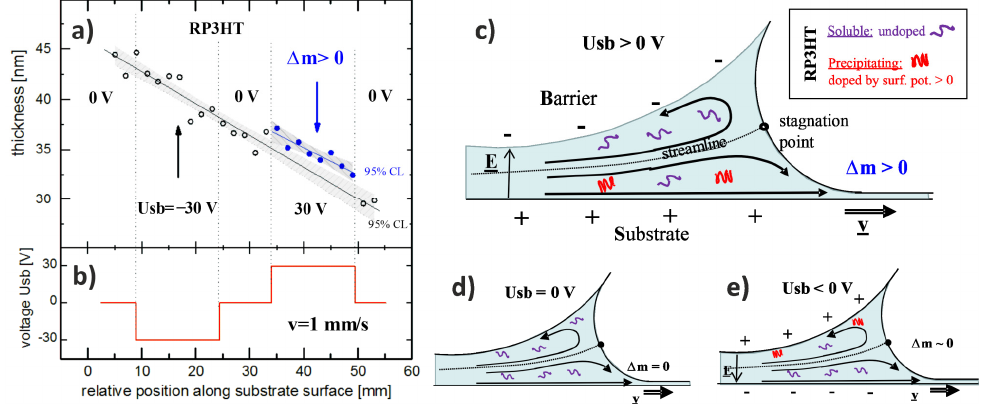
Figure 5. Electrically controlled content of RP3HT in the solution-coated films based on a novel mechanism involving ( a , b ) voltage-controlled RP3HT solubility and ( c – e ) flow pattern asymmetry between the stationary barrier and moving substrate during the H-dip coating process. The film thickness of a pristine RP3HT layer ( a ), determined after H-dip coating (from chlorobenzene, 15 mg/mL, v = 1 mm/s), and the voltage Usb ( t ) ( b ) imposed between the substrate and barrier in the course of coating are plotted as a function of the position along the layer. The extents of nonzero voltages are indicated by the vertical dotted lines. ( c – e ) Qualitative sketch of streamlines, typical for dip coating, in which the coating solution layer is split into two around a stagnation point, with the lower part entrained by the substrate and the upper one returning along the barrier to the reservoir in the meniscus. This situation introduces an asymmetry (with respect to Usb ) to the solubility control and hence to the RP3HT content variation in the coated composites.